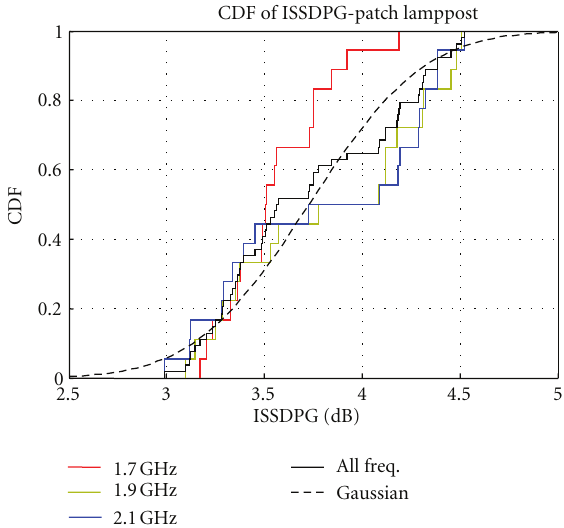
Figure 27: ISSDPG distribution for lamppost